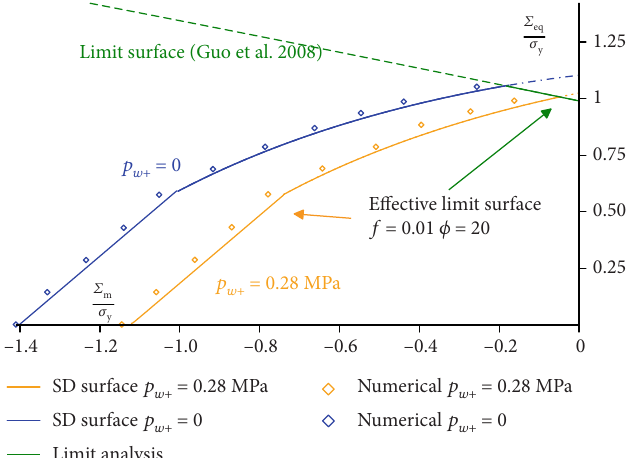
Figure 11: Comparison between the proposed macroscopic criterion and numerical results with respect to p angle of the solid matrix ϕ = 20 °